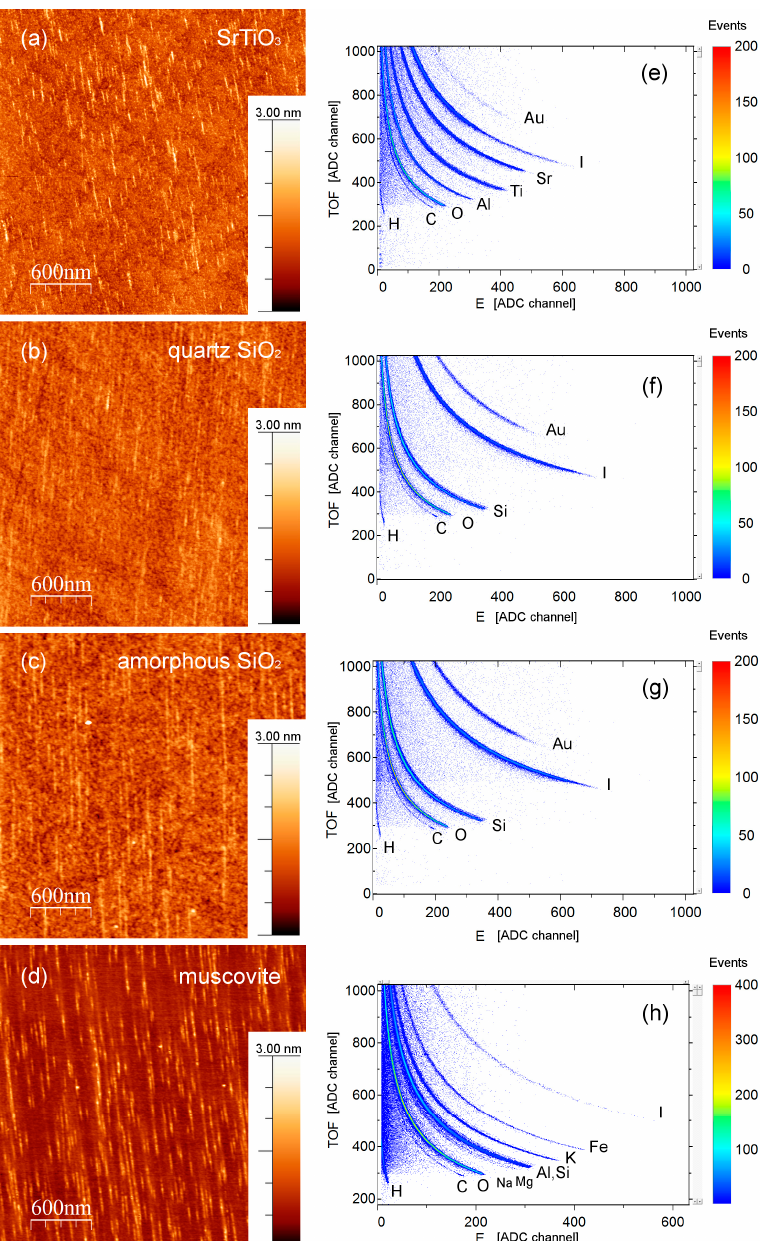
Figure 3. Ion tracks on the material´s surfaces produced by 23 MeV I ions under a grazing incidence angle of 1°, observed by atomic force microscopy (AFM): ( a ) SrTiO 3 ; ( b ) quartz SiO 2 ; ( c ) amorphous SiO 2 ; ( d ) muscovite mica. In all cases, the applied ion fluence matches well the observed ion track density. Corresponding grazing incidence time-of-flight elastic recoil detection analysis (ToF-ERDA) spectra obtained by the same 23 MeV I beam are shown in panels ( e – h ). Detection of iodine is from the primary ion beam, while detected Al and Au are from the gold coated aluminum sample holder.